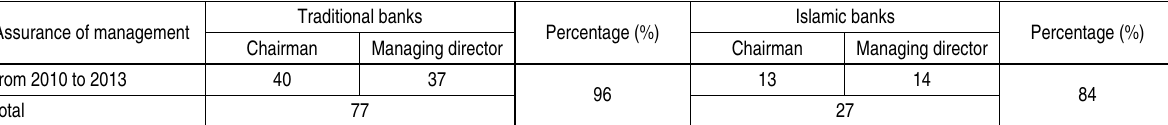
Table 4. Top level management commitment on CSR performance